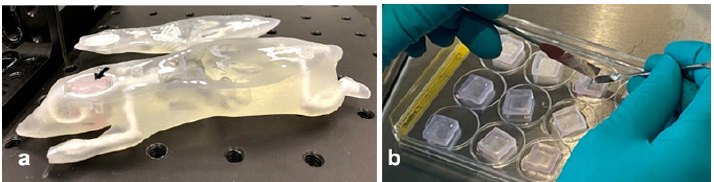
Figure 7. Mouse phantom generated in an additive manufacturing process (3D printing) with tissue equivalent materials, with 3D bioprint generated from primary brain tumor cell inserted ( a ). The black arrow points at the bioprint. Well plate with 3D bioprints in cases ( b